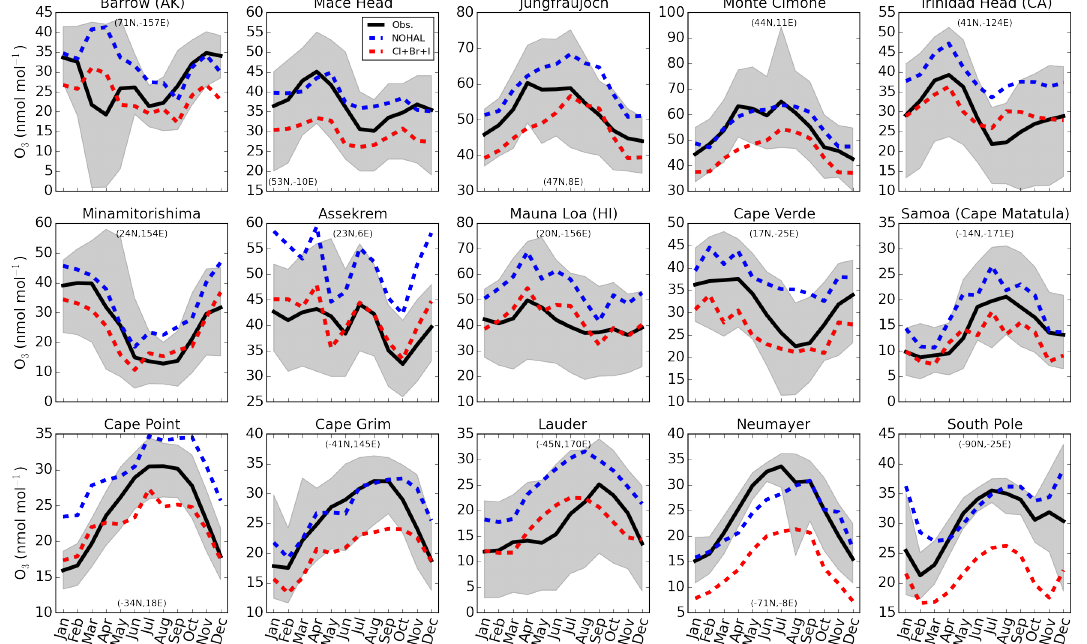
Figure 13. Seasonal cycle of near-surface O 3 at a range of Global Atmospheric Watch (GAW) sites. Observational data shown are 6-year monthly averages (2006–2012). Model data are for 2005. Data are from GAW, compiled and processed as described in Sofen et al. (2016). Blue and red lines represent simulations without halogens (“NOHAL”) with halogens (“Cl + Br + I”), respectively. Grey shaded area gives 5th and 95th percentiles of the observations. Locations of observations are shown in Fig.